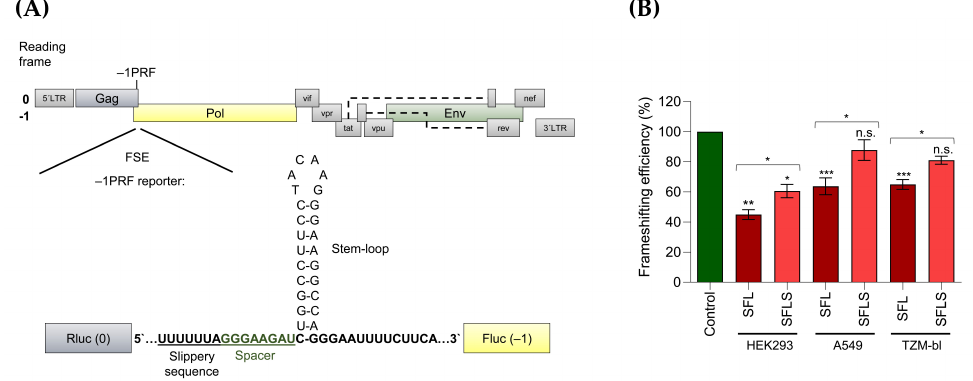
Figure 1. SFL inhibits HIV –1PRF in a cell-line-independent fashion. ( A ) Schematic illustration of the HIV-1 genome, including the site of –1PRF and the FSE. For quantification of –1PRF, the FSE sequence including the heptanucleotide slippery sequence, spacer, and stem-loop from the HIV-1 mRNA was inserted between Renilla luciferase (Rluc) (0 reading frame) and Firefly luciferase (Fluc)